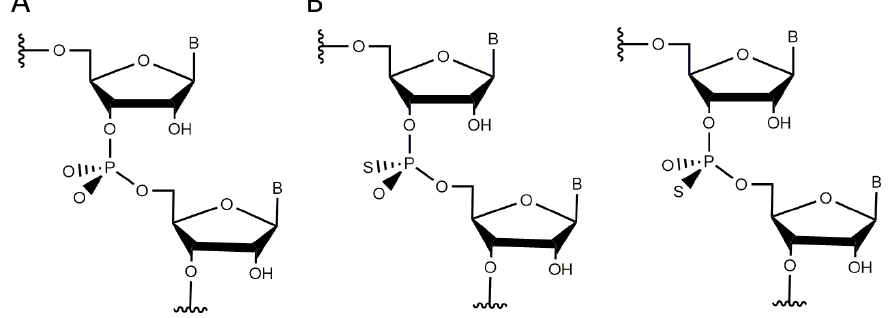
Figure 6. Conformations of the non-brinding oxygen atoms in a phosphodiester bond. ( A ) Prochiral phosphodiester bond between two nucleotides illustrating the absolute positions of the pro - R and pro - S non-bridging oxygens. ( B ) S P or R P phosphorothioate diastereomers after substitution of one of the identical non-bridging oxygen atoms by a sulfur